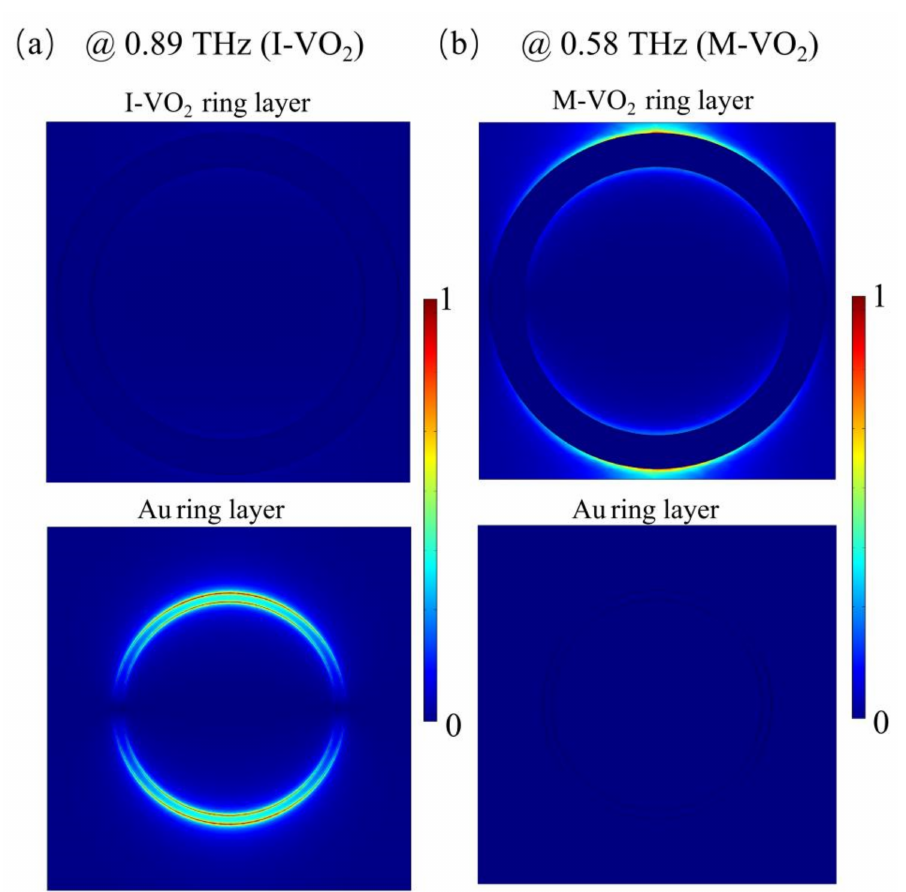
Figure 3. The electric field distributions of the VO 2 -ring array layer and Au-ring array layer at the absorption peaks when the VO 2 is in the dielectric and metallic